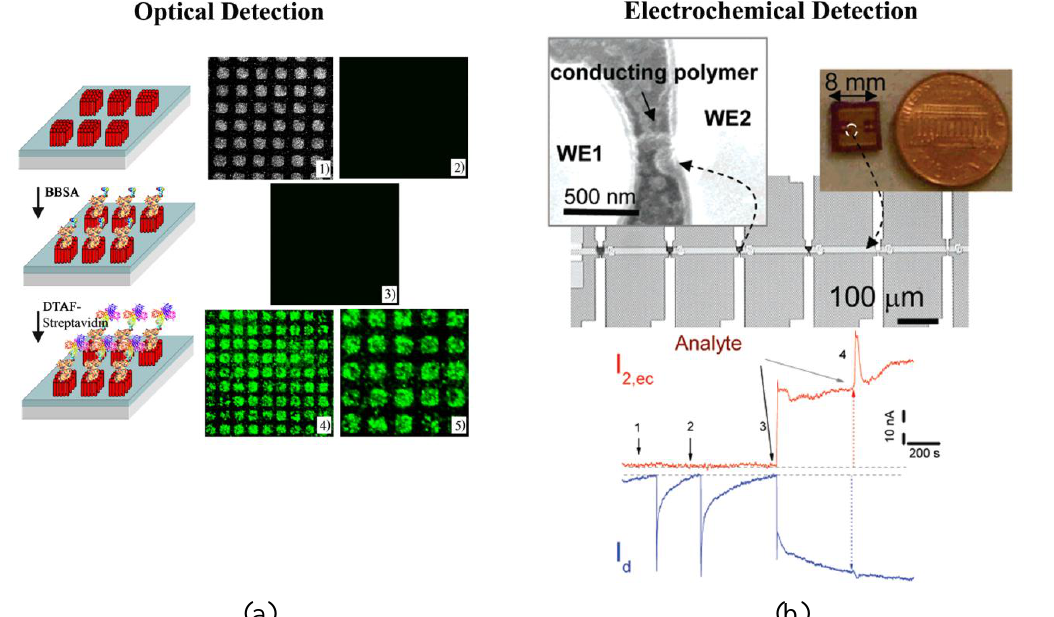
Figure 1. Different modes of protein sensors; ( a ) optical, ( b ) electrochemical, ( c ) electrical, and ( d ) mass-sensitive biodetectors. Adapted with permission from